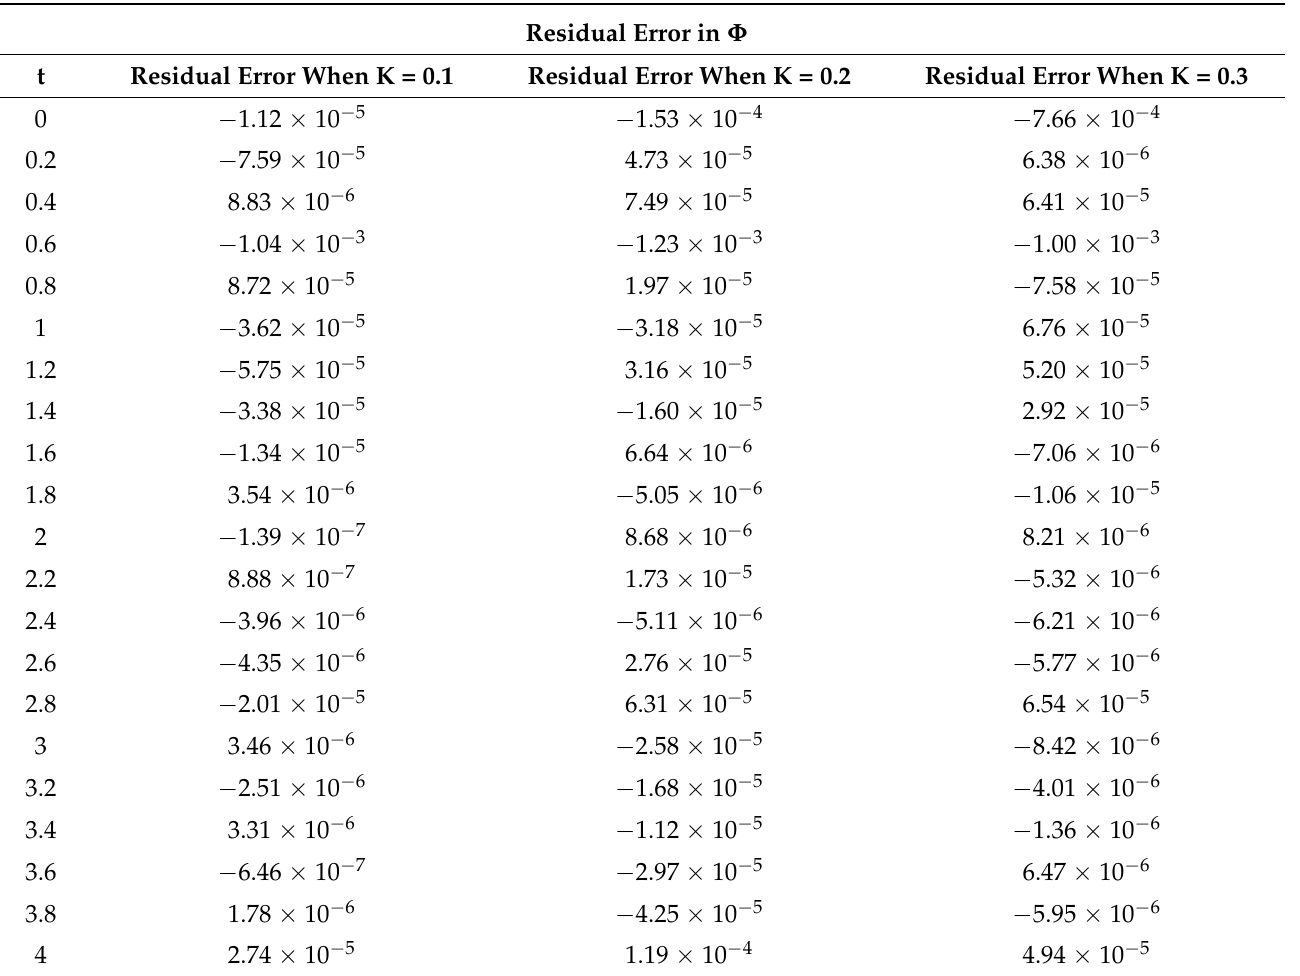
Table 10. Residual error in RK4 and LMB-NN in Φ